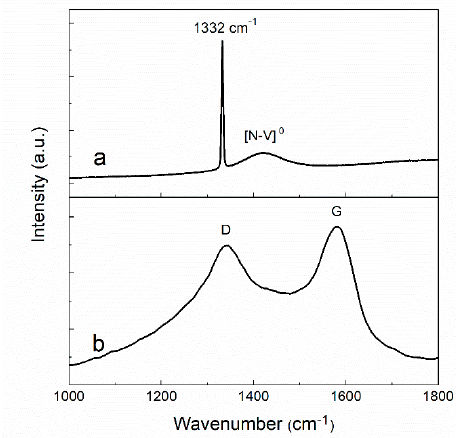
Figure 5. Raman spectra of ( a ) virgin surface and ( b ) inside laser-ablated area.